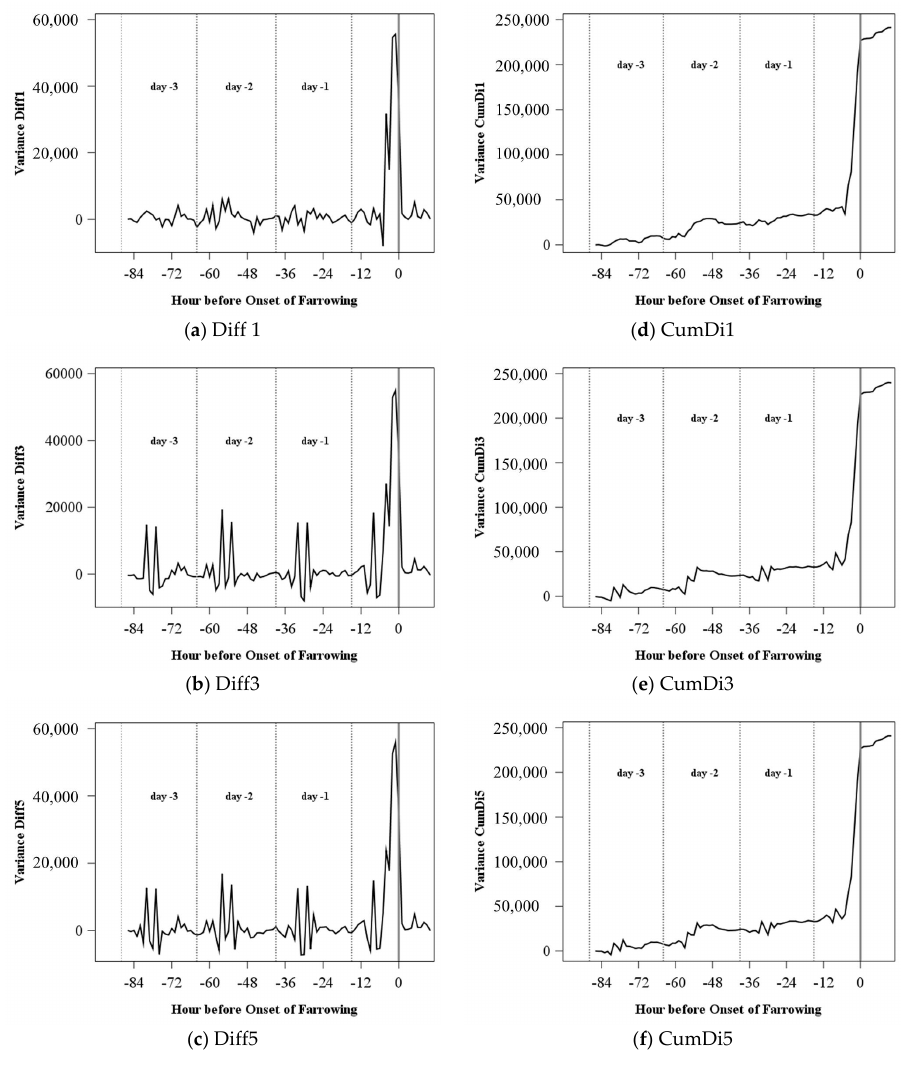
Figure 5. The range (1, 3, 5) for the moving average in acceleration indices Diff ( a , b , c ) and CumDi for 60 min period ( d , e , f ) of the distribution characteristic variance for one sow. Note that 0 indicates the onset of